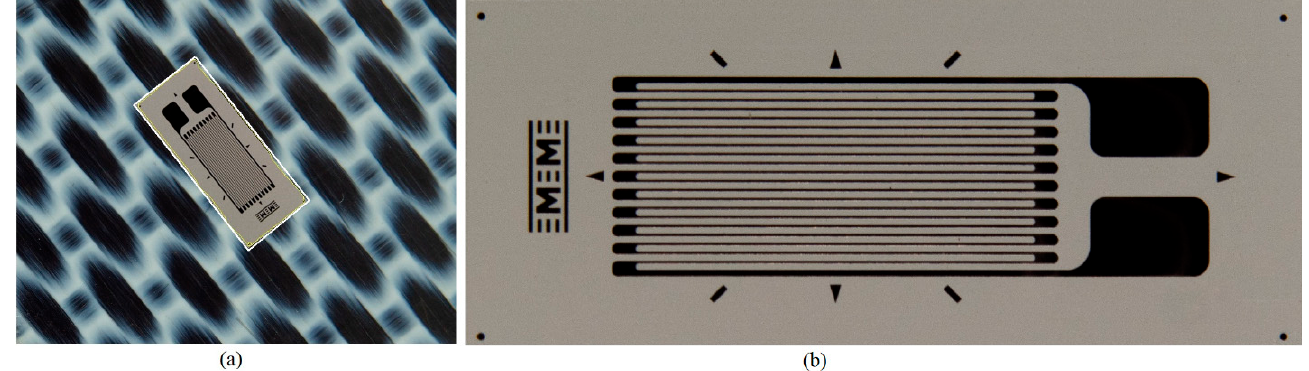
Figure 7. Image extraction of SG and orientation in approximately horizontal position: ( a ) phase 1 and ( b ) phase 2.